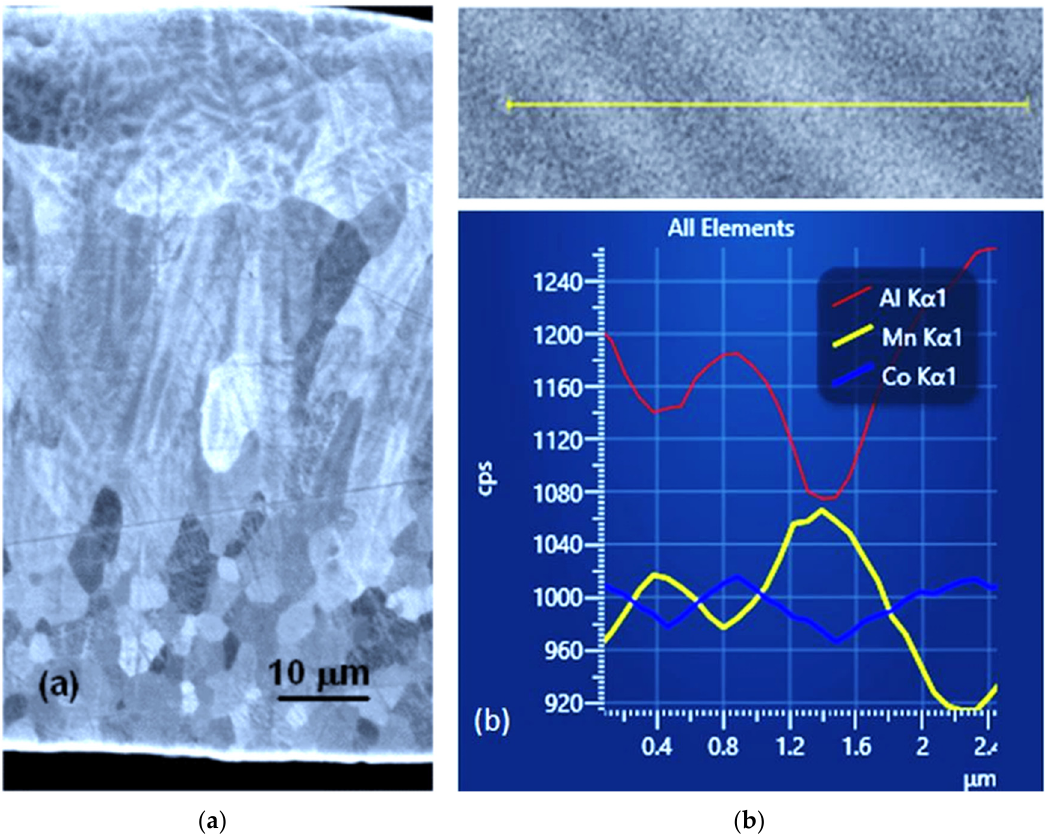
Figure 4. ( a ) Observation in the BSE regime of the ribbon cross-section revealed small grains at the ribbon surface in contact with the wheel, columnar crystals grown by cellular or dendritic growth with darker cell centres, and randomly oriented big grains grown by dendritic growth located at the ribbon free surface. ( b ) EDS line analysis through growth lines and records across the growth lines (cps: counts per second) in columnar grains show that the darker parts are enriched in Co and Al and the brighter parts are enriched in Mn.